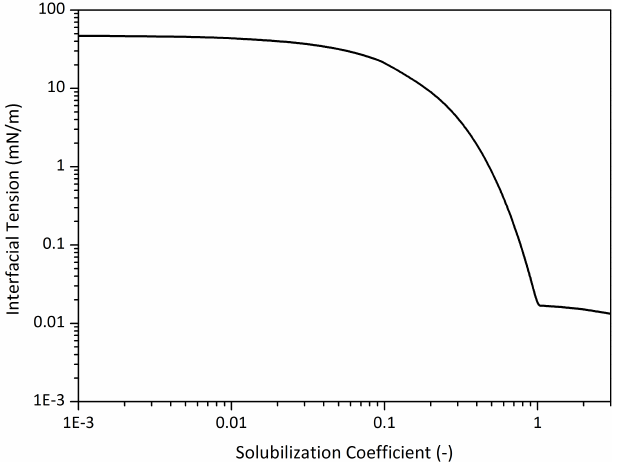
Figure 5. Interfacial Tension [mN/m] as a function of the solubilization coefficient ( L a pc ) for a Type II( − ) emulsion with a partition coefficient k c =